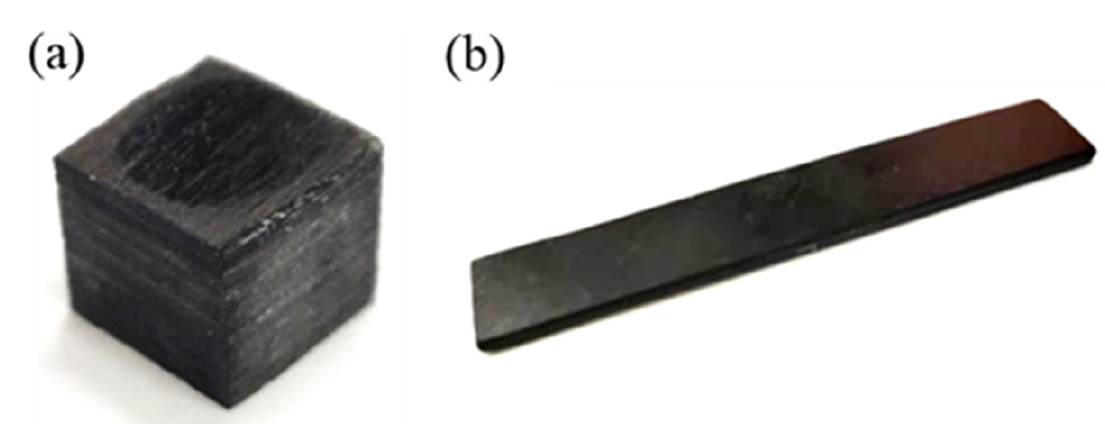
Figure 2. ( a ) Dynamic compression sample and ( b ) dynamic bending sample of CFRP laminates.